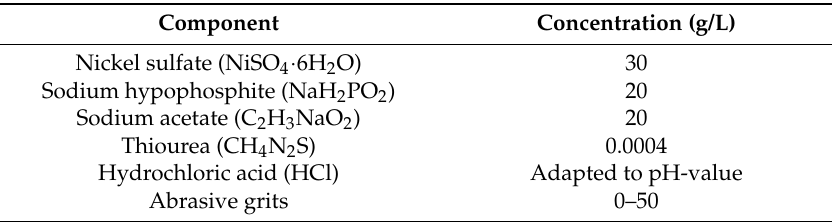
Table 1. Composition of electroless plating solution.